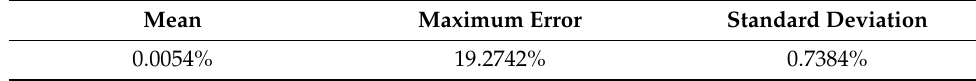
Table 6. Ratio between statistical measures: testing A.